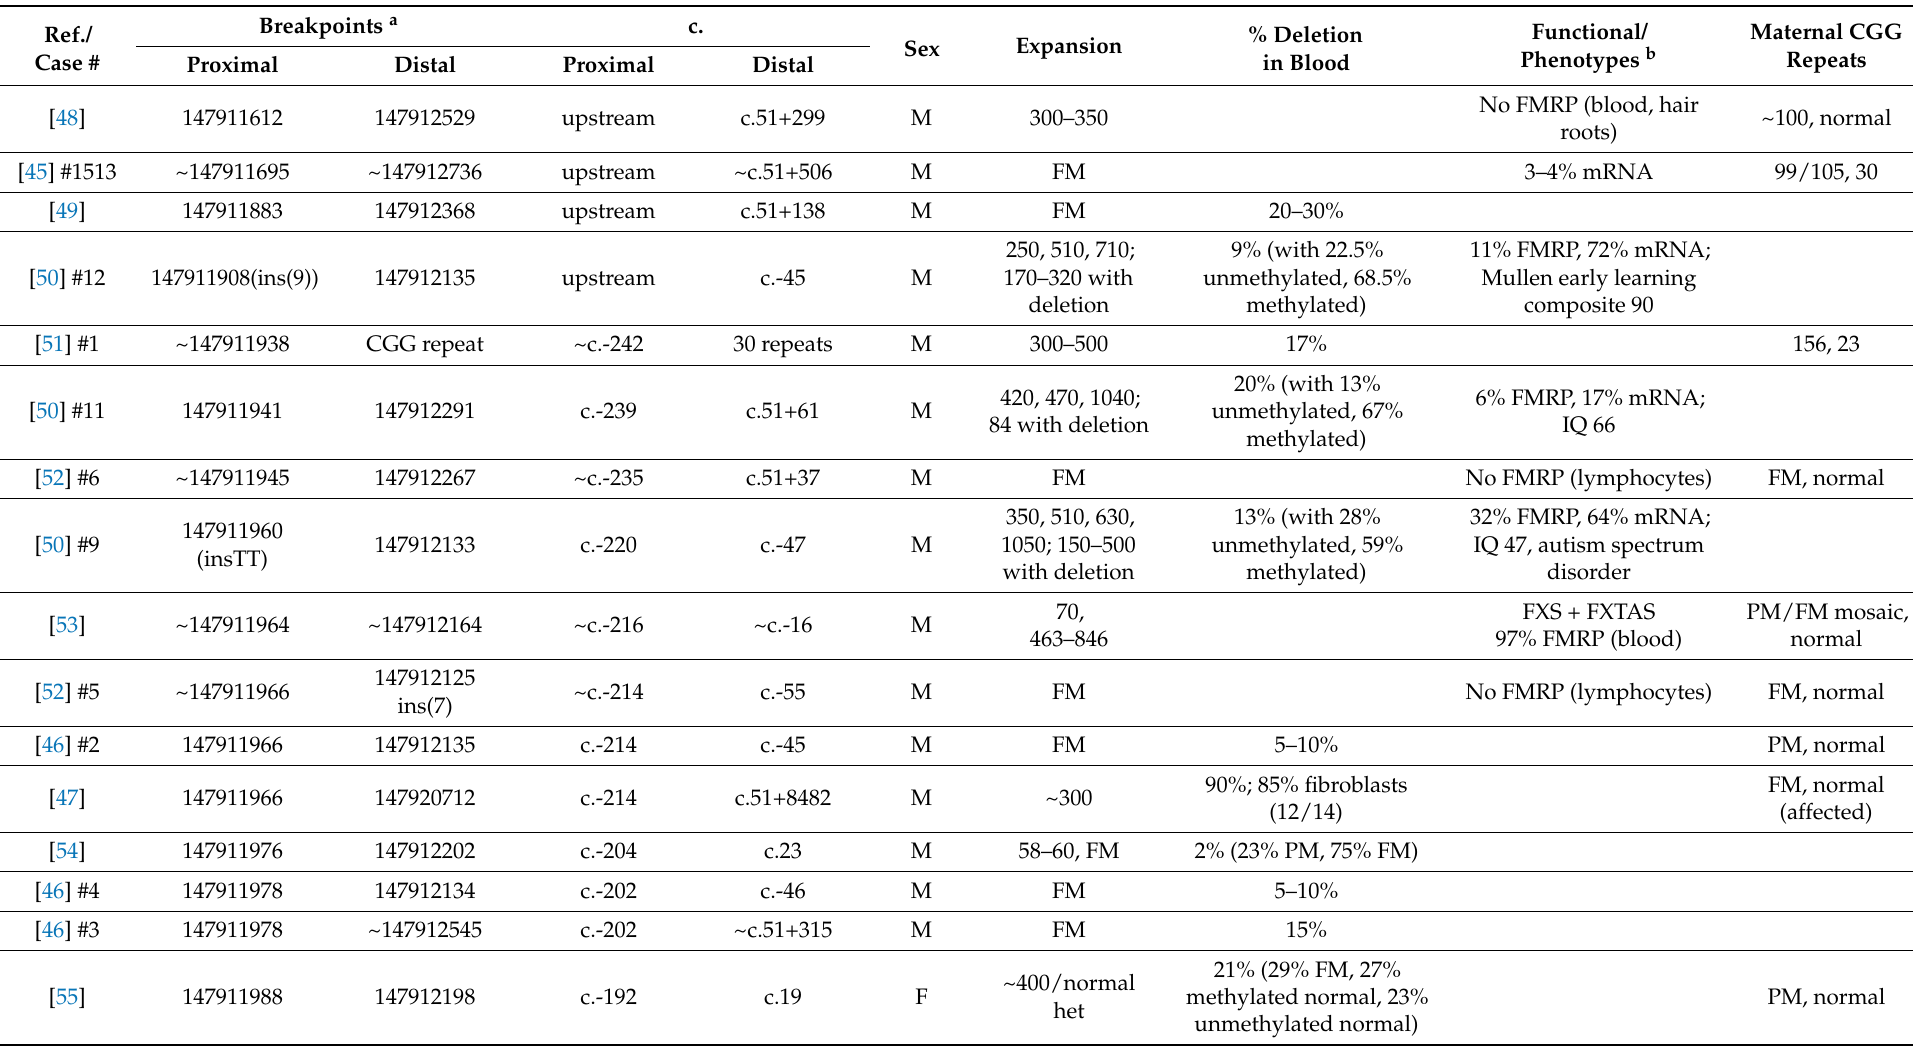
Table 2. Mosaic deletions extending outside the CGG repeat region in patients with FMR1 repeat expansions.